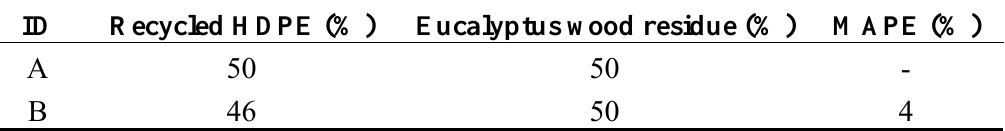
Table 1. Description of the manufactured samples.